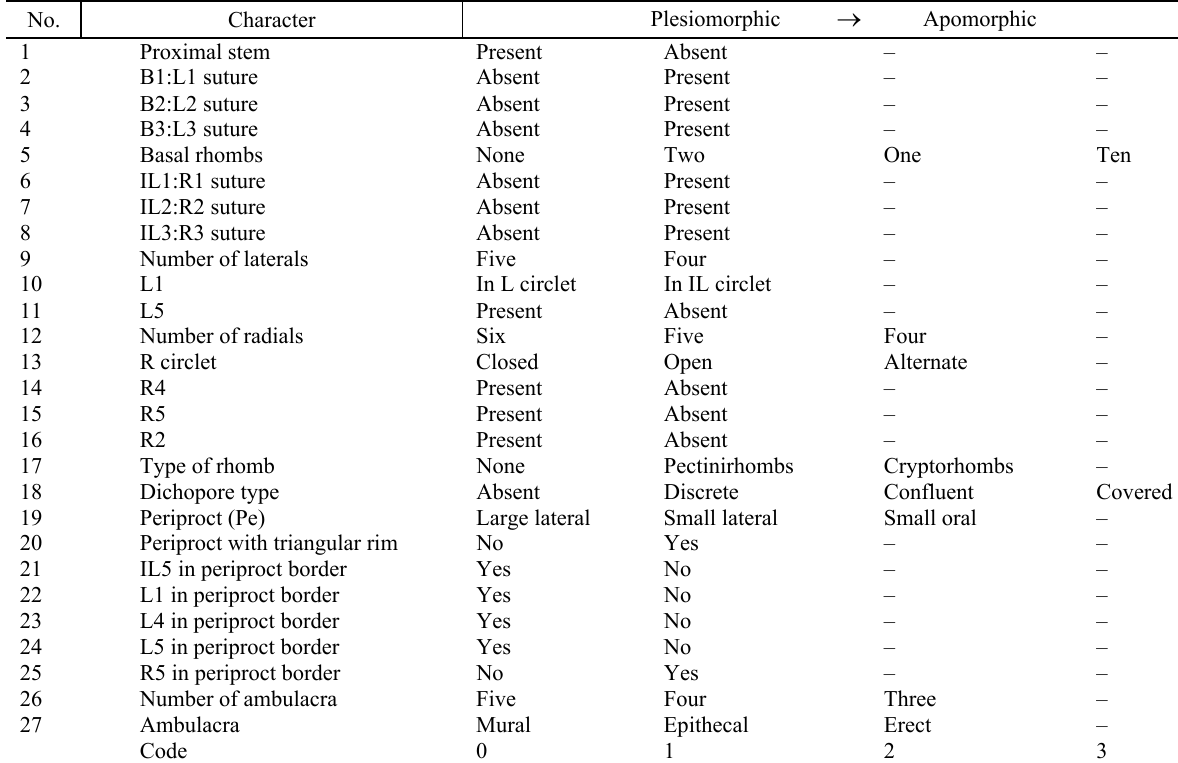
Table 2. Character states in Cystoblastus